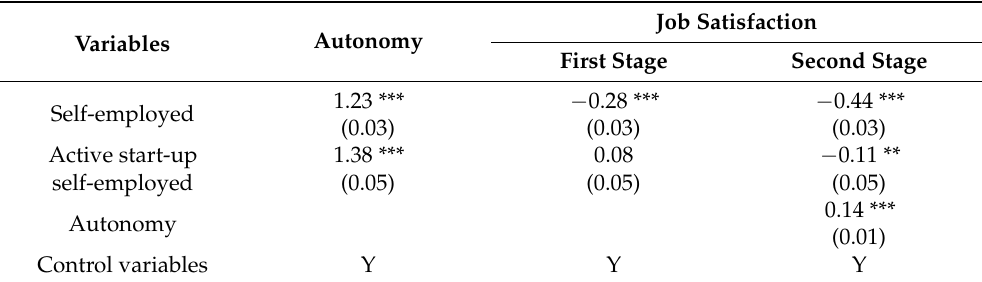
Table 5. OLS regression results of the effect of self-employment on job satisfaction mediated by autonomy. Variables Autonomy